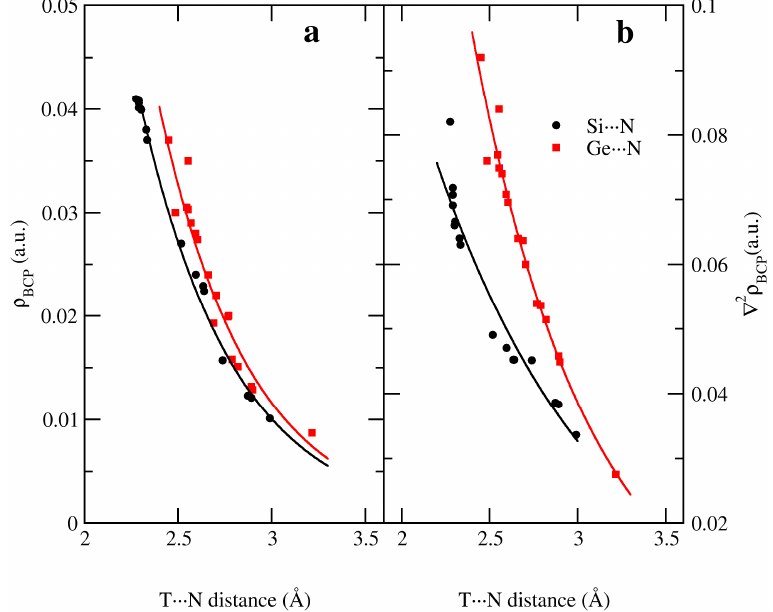
Figure 3. Exponential relationships between ( a ) electron density at the bond critical point and ( b ) Laplacian at the bond critical point with the intermolecular T···N distance at the MP2/aug-cc-pVTZ computational level.